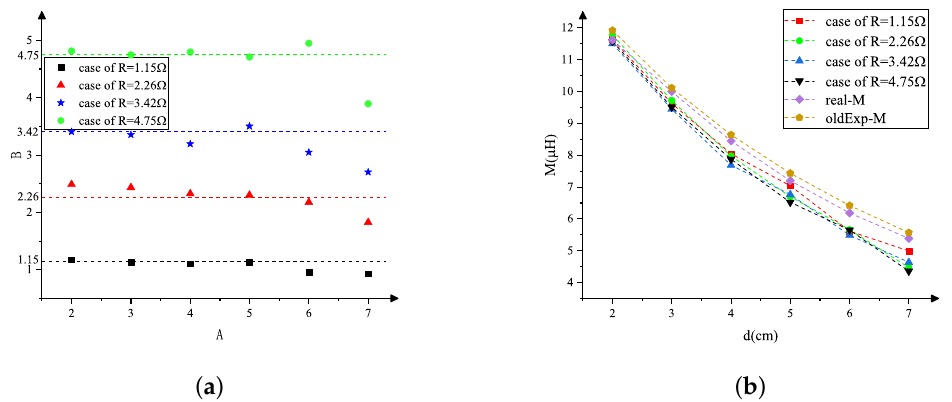
Figure 12. Experimental results for load resistances and mutual inductances. ( a ) Load resistance; ( b ) mutual